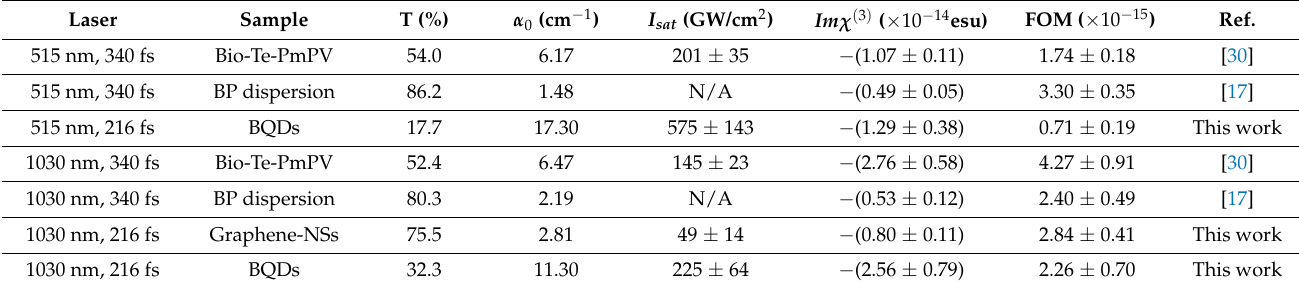
Table 1. Nonlinear optical coefficients of BQDs and other